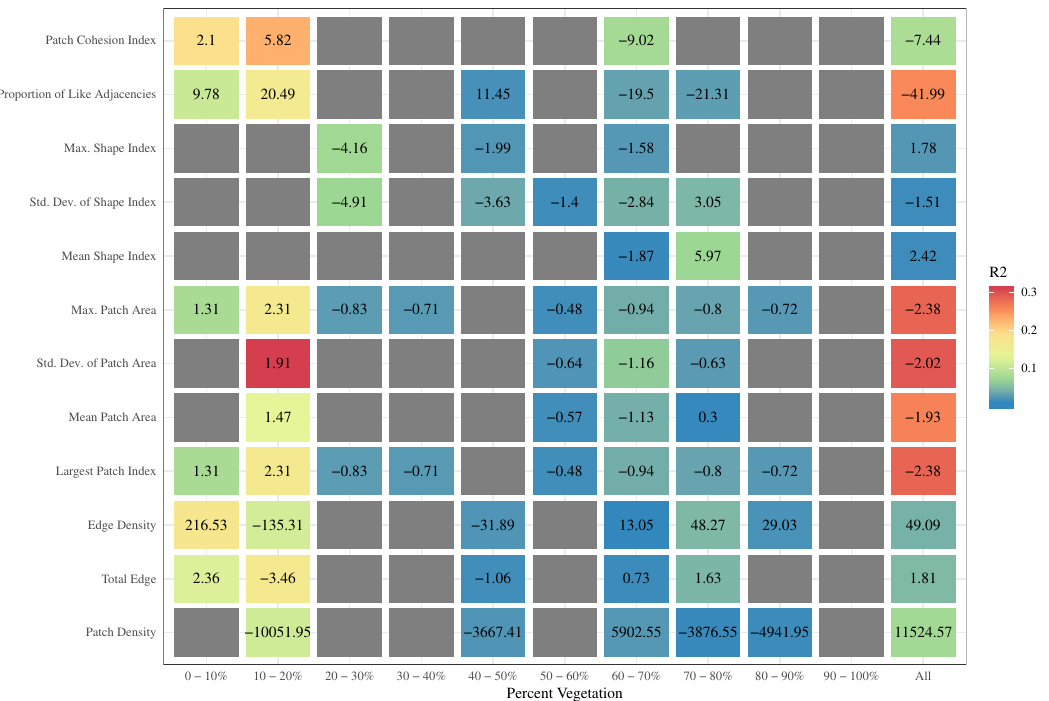
Figure 7. LST regressed on the metrics for each percent vegetated class. The numbers are the slope coefficient for models significant at p ≤ 0.05 and the color indicates the R 2 value of the regression models. The rightmost column is LST regressed on the metrics without controlling for the percent of vegetation.